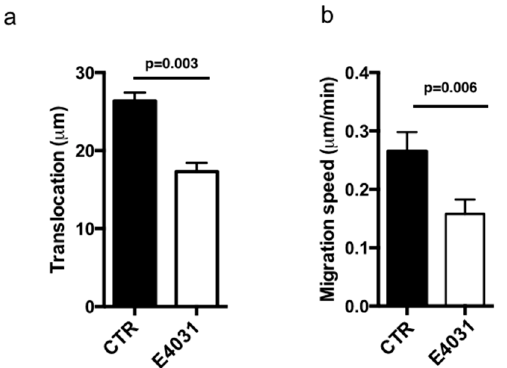
Figure 3. Cell migration of PANC-1 cells cultured onto FN. ( a ) Translocation data. Cells were incubated on FN in the absence (CTR) or in the presence of 40 µ M E4031 (E4031). Images of at least 40 cells acquired during 4 h time lapse were analyzed using ImageJ and it was calculated as the net distance between the starting and the end position of the cell. Data are reported as mean ± SEM. All p -values were determined by a Mann–Whitney test (significant level set to p < 0.05), or for data deviating from normality by a Kolmogorov–Smirnov test. ( b ) Migration speed data. Cells were incubated on FN in the absence (CTR) or in the presence of 40 µ M E4031 (E4031). Images of at least 40 cells acquired during 4 h time lapse were analyzed using ImageJ. Migration speed was calculated as the distance travelled by the cell center per min. Data are reported as mean ± SEM. All p -values were determined by a Mann–Whitney test (significant level set to p < 0.05), or for data deviating from normality by a Kolmogorov–Smirnov test.